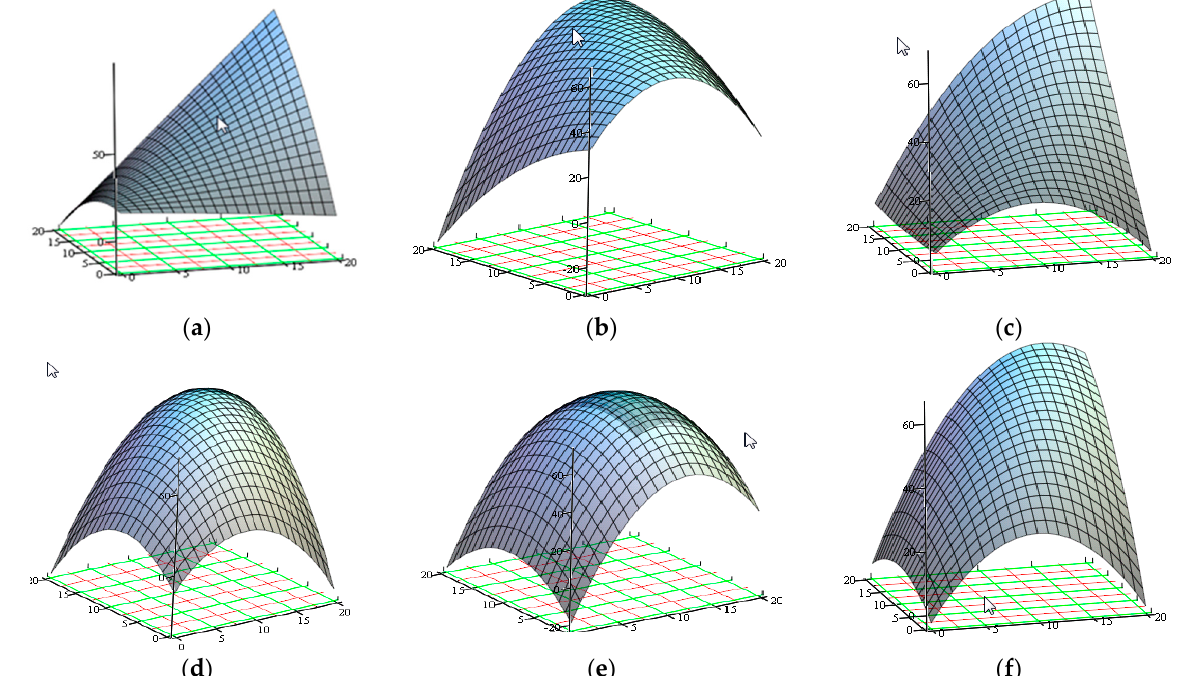
Figure 1. The 3D surface plots of degree of hen gizzards hydrolysis as a function of factors—when treated with Propionix LCSC: ( a ) interactions of temperature and time of hydrolysis on DH; ( b ) interactions of temperature and the amount of starter culture; ( c ) interaction of the amount of starter culture and hydrolysis time on DH; when treated with BLC: ( d ) interactions of temperature and time of hydrolysis on DH; ( e ) interactions of temperature and the amount of starter cul- ture; ( f ) interactions of the amount of starter culture and hydrolysis time on DH. DH = degrees of hydrolysis.